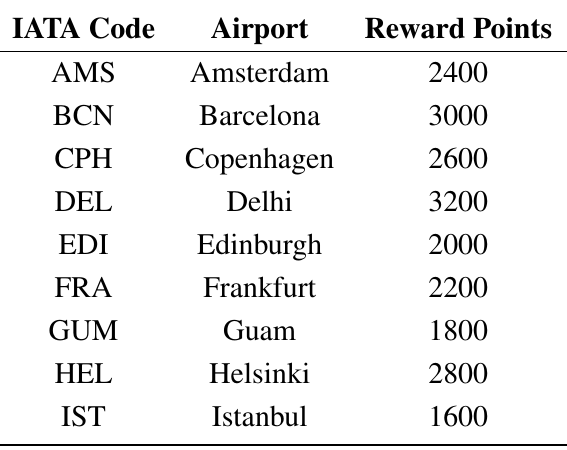
Table 2. Auxiliary information for the uncertain big data in Table